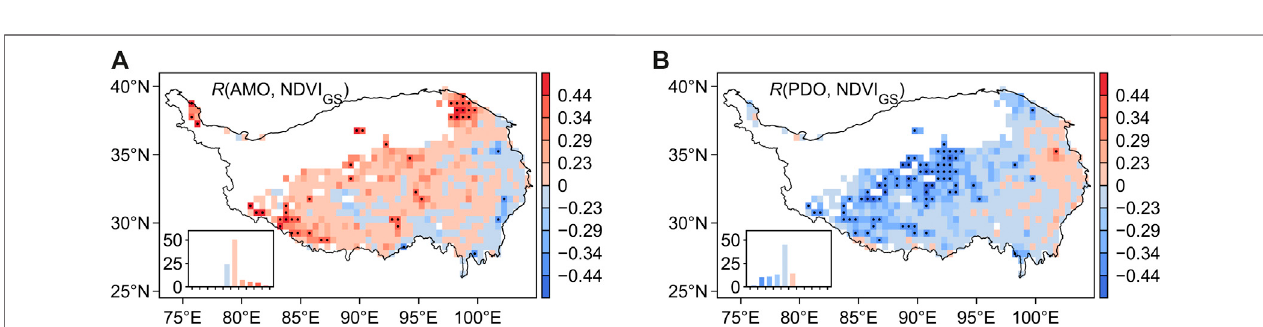
FIGURE 6 | Spatial pattern of correlation coef fi cients between the NDVI GS and annual AMO (A) or PDO (B) index. R (cid:2) ± 0.44, R (cid:2) ± 0.34, R (cid:2) ± 0.29, and R (cid:2) ± 0.23 correspondtosigni fi cancelevels P (cid:2) 0.01, P (cid:2) 0.05, P (cid:2) 0.10,and P (cid:2) 0.20,respectively.Pixelswithdotswerestatisticallysigni fi cant( P < 0.05).Bottom-leftinsetineach map shows the percentage of pixels in each interval of correlation coef fi cient with the interval value indicated by the color in the legend in the right.